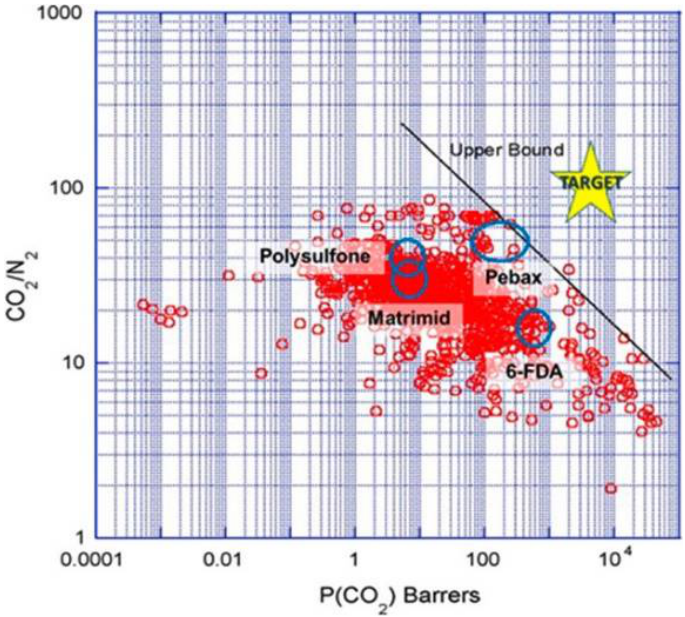
Figure 5. Correlation between polymer selectivity and permeability. Reproduced with permission from [66], John Wiley and Sons,